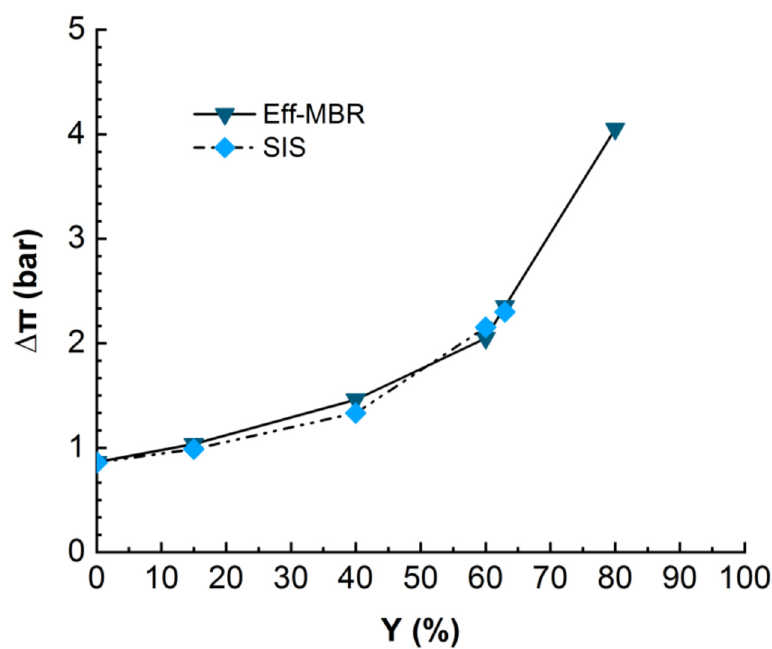
Figure 5. Evolution of differential osmotic pressure in NF for real MBR effluent (duration of the experiment = 24 h) and SIS (duration of the experiment = 18 h). TMP = 10 bars, T ◦ = 20 ◦ C.